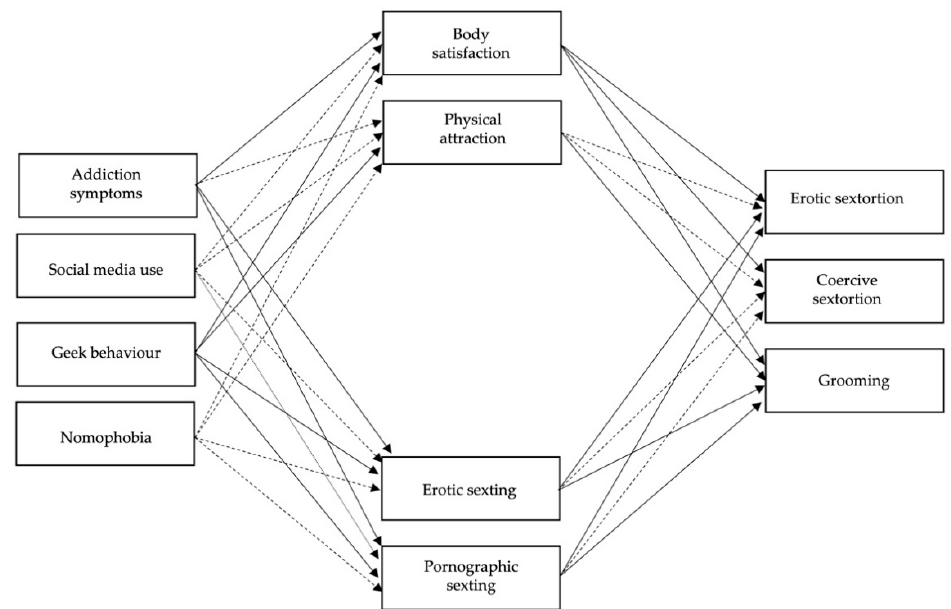
Figure 2. Tested structural equation model with complete mediation: interplay between internet and social networking addiction and sexual online victimization mediated by body self-esteem and sexting. Note . Continuous pathways are significant at p < 0.01, dotted pathways are not significant. The relationships of the factors with their indicators have not been drawn for simplicity.